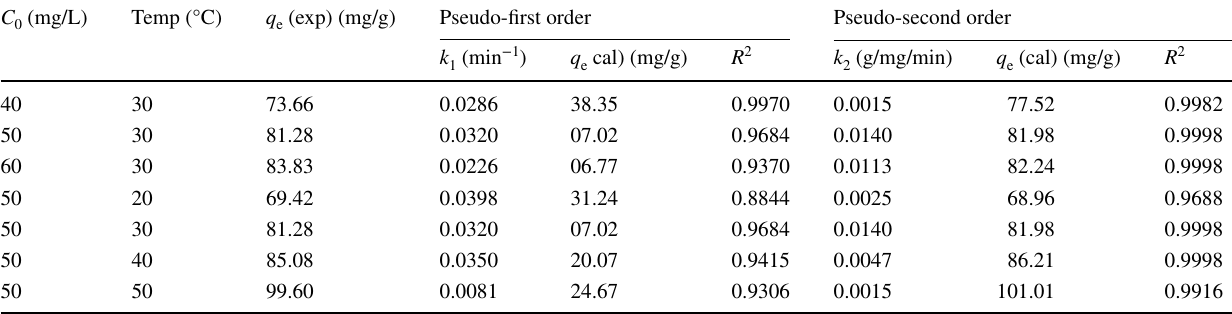
Fig. 6 Pseudo-second-order plot at different concentrations and temperatures Table 3 Comparison of pseudo-first-order and pseudo-second-order kinetic parameters